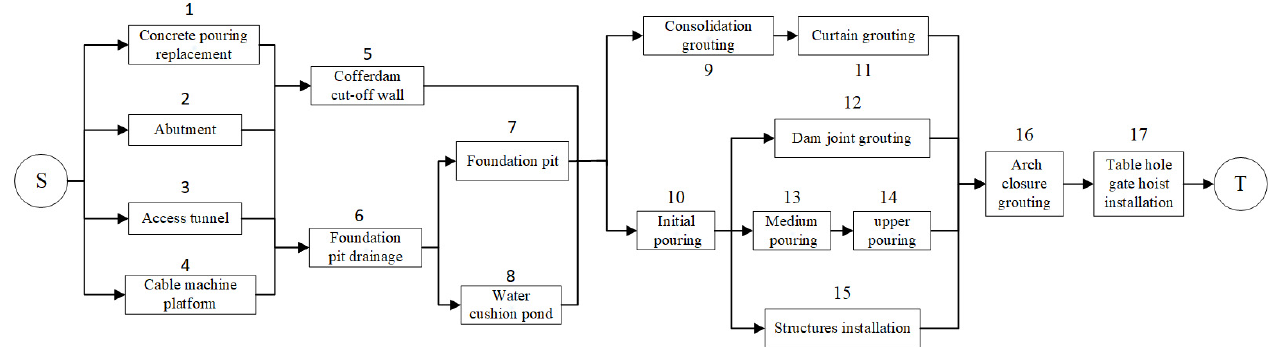
Figure 5. Construction flow chart of a concrete double-curvature arch dam.